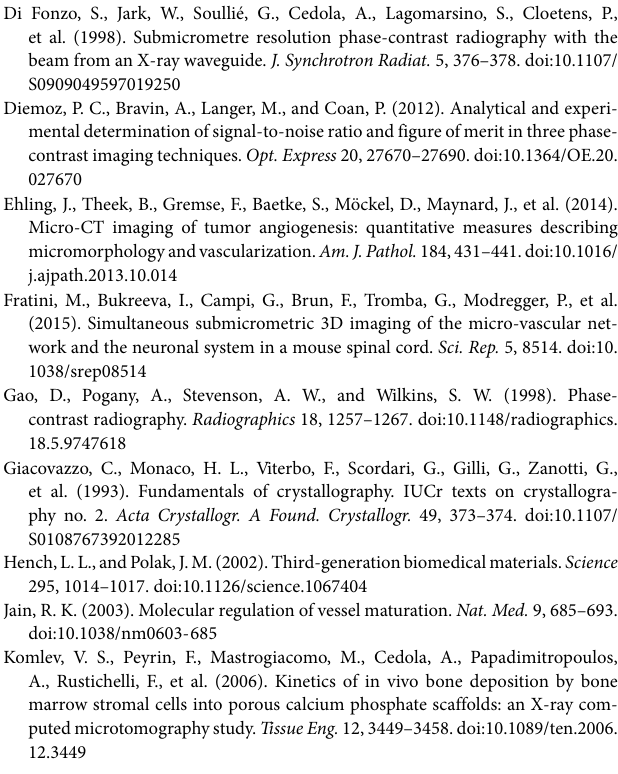
Figure S1 | Hystological images of engineered Skelite scaffolds stained by MICROFIL ® . (A , C , E) scaffold not seeded with cells; (B , D , F) scaffolds seeded with cells. (A , B) scalebar = 500 μ m; (C , D) scalebar = 200 μ m; (E , F) scalebar = 100 μ m. Arrows indicate vessels marked by MICROFIL. Acquisition by Zeiss Axiovert 200M ( sk = Skelite; ft = fibrous tissue; b = bone tissue; m = MICROFIL ® ). Video S1 | (a) 3D reconstructions of a volume of about 400 slices of the sample B. We segmented in red the MICROFIL ® and the scaffold, while in green-yellow the soft